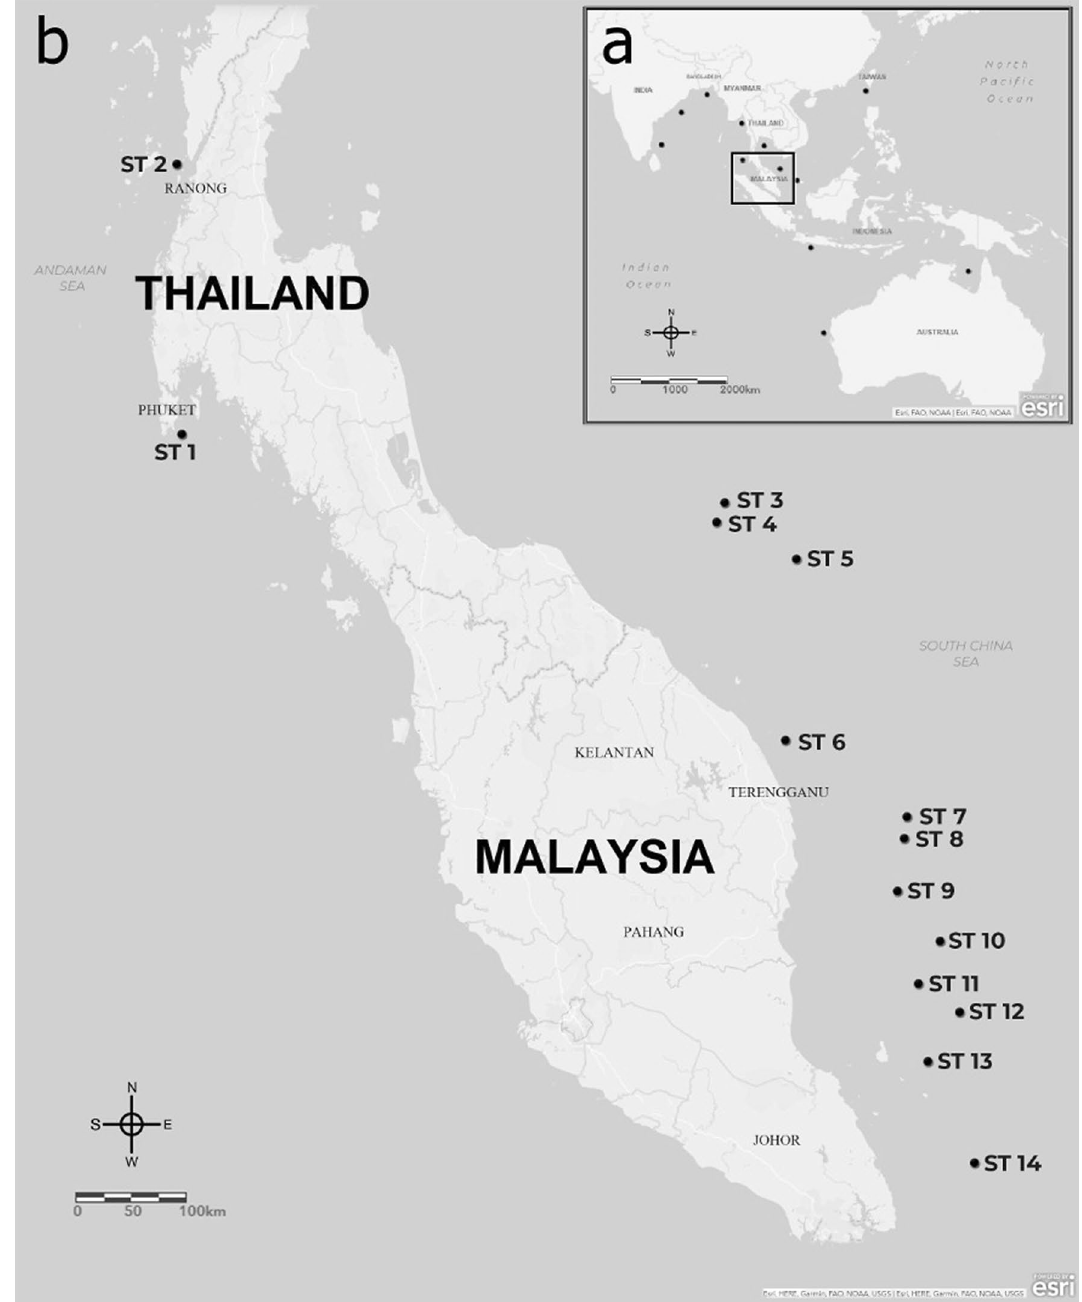
Figure 1. Distribution of Uranoscopus cognatus ( a ) based on reports of occurrence (indicated by black dots). Squared area indicates sampling locations in this study ( b ) Fourteen sampling stations (ST) of U. cognatus divided into two geographical regions i.e. the west coast of Thailand (WCT) (ST1-2) and the east coast of Peninsular Malaysia (ECPM) (ST3-14). (The map was created in ArcGIS Online, https:// www. esri. com/ en- us/ arcgis/ produ cts/ arcgis- online/ resou